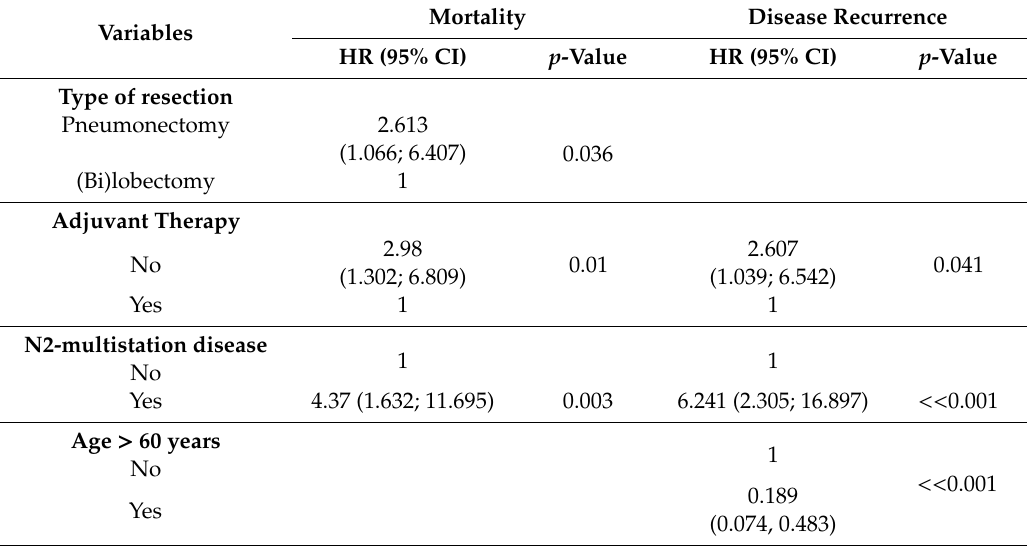
Table 4. Hazard ratios (HR [95% confidence interval (CI)]) for mortality and disease recurrence; p -value from Cox